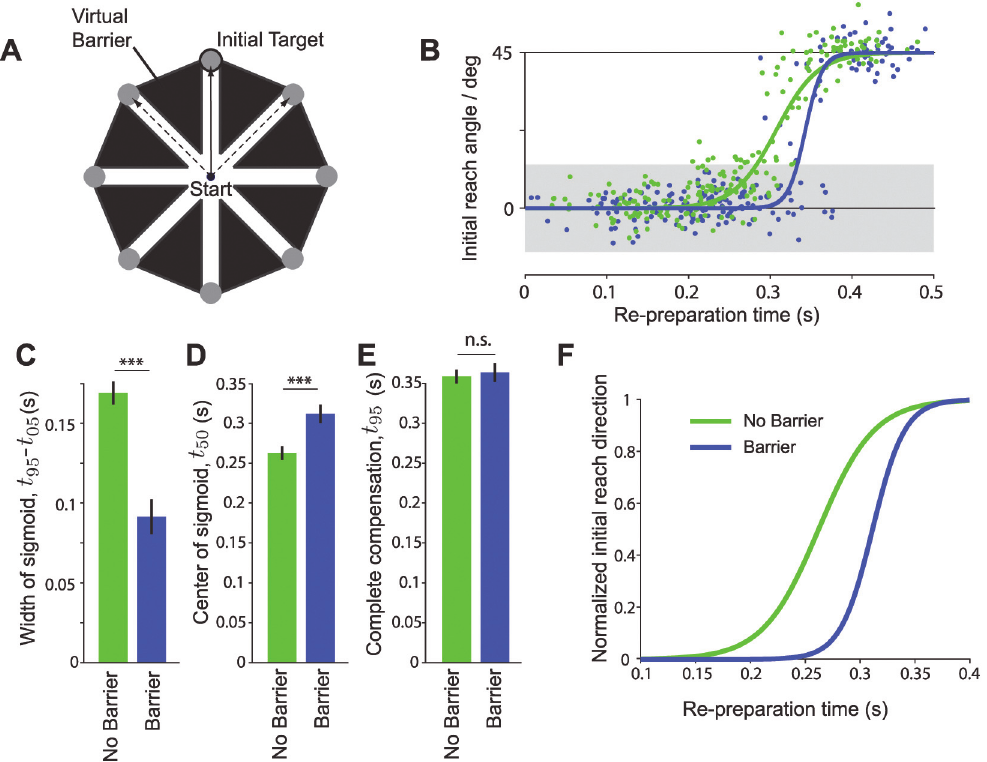
Fig 5. Experiment 3 results. A) The experimental setup was as experiment 1 (Fig. 1A), except that in one condition a series of virtual barriers was put in place to penalize subjects for making intermediate movements. In this experiment, the target only jumped by ± 45°, and did so on 30% of trials. Solid arrow/ bold target indicates movement required before target jump. Dashed arrows indicate potential movements required after a target jump. B) Behavior on jump trials for a representative subject. Blue points indicate individual trials from the session in which barriers were present. Green points indicate individual trials in which the barriers were absent. Solid lines indicate sigmoidal fit. Shaded region indicates 95% confidence interval for movement direction based on trials from the no-barriers session in which the target did not jump. C) — E) Estimated sigmoid parameters across subjects (as Fig. 3A-C). F) Average sigmoid fit to behavior across all subjects following a target